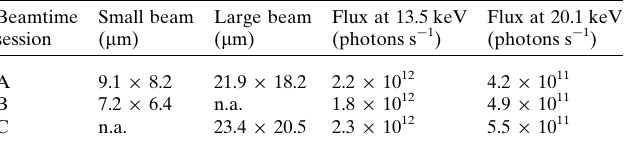
Table 1 Beam sizes (FWHM) of the Gaussian-shaped beam and the fluxes measured with a 500 m m thick silicon PIN diode for the three different sessions reported here. Beamtime session